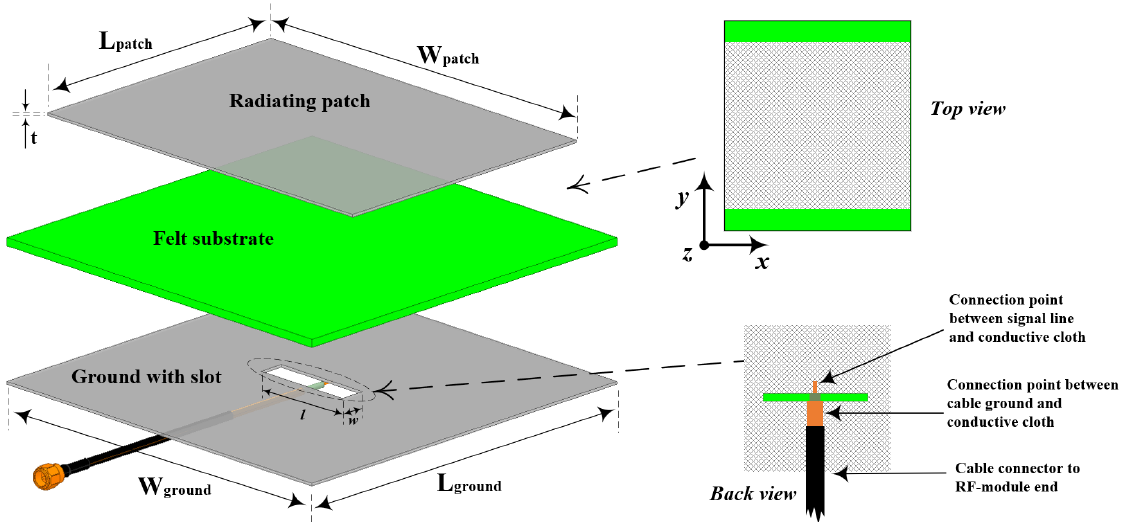
Figure 7. Conceptual views of the coaxial aperture-feeding technique (see Table 2 for dimensions).